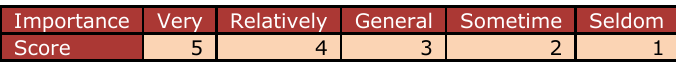
Table 3. Check list of Importance and